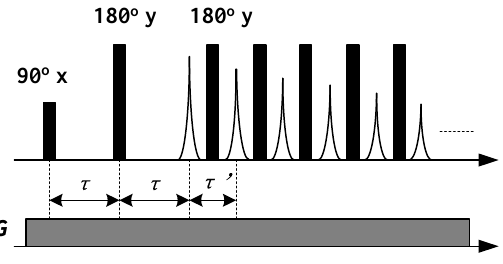
Figure 2. SGSE sequence composed of a Hahn echo and a CPMG